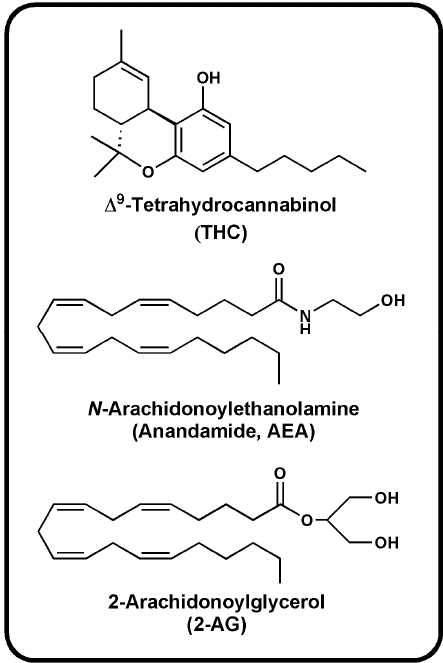
Figure 1. Chemical structures of THC and two prominent